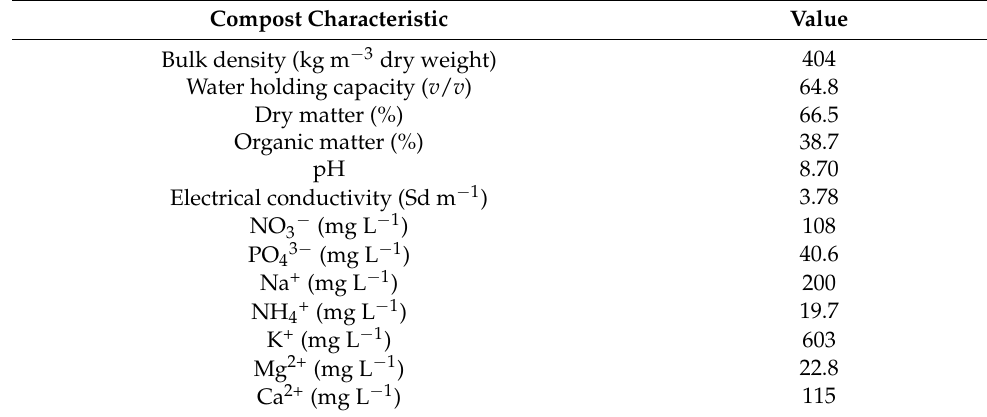
Table 1. Chemical and physical properties of the garden waste compost considered for the evaluation of the impacts.